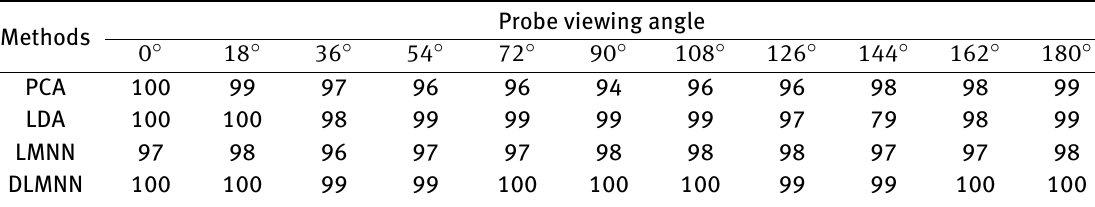
Table 3: The recognition rates (%) of different methods in no-variation condition evaluated on CASIA-B.